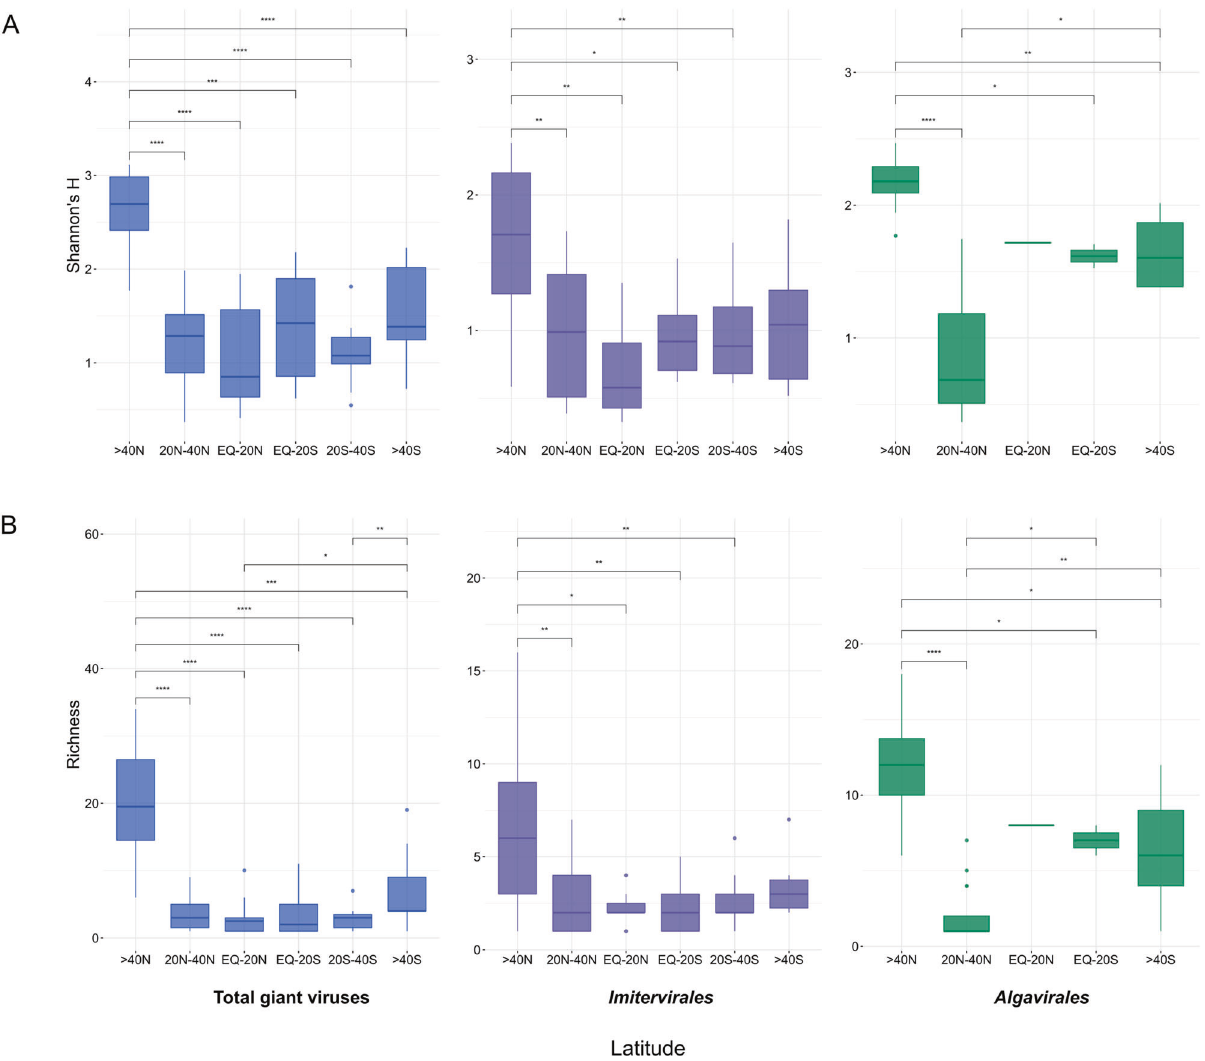
Fig. 6 The latitudinal pattern of giant virus diversity across the transect GA02. Diversity was calculated using ( A ) Shannon ’ s H index and ( B ) Genome richness. Shannon index calculations were based on the viral abundances (in RPKM) produced from 10 M subsampled reads. Stars showing signi fi cant difference between two latitudinal groups (Wilcox test, p values < 0.05) (* <0.05, ** <0.01, *** <0.001, **** <0.0001) Panels left: Total virus community; center: Imitervirales communities; right: Algavirales communities. EQ